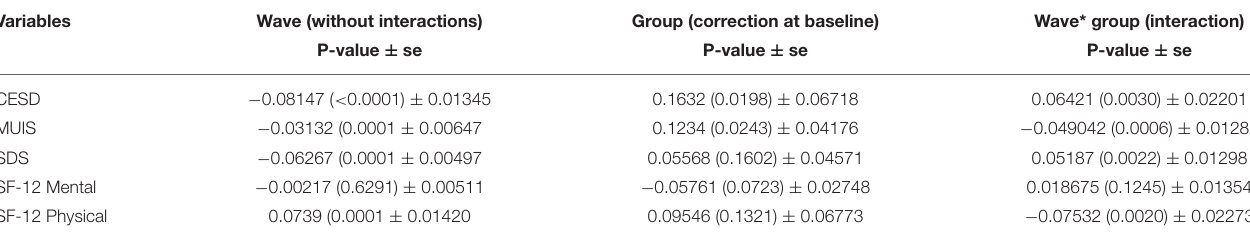
TABLE 4 | Results of mixed-effect regression models with identified variables.